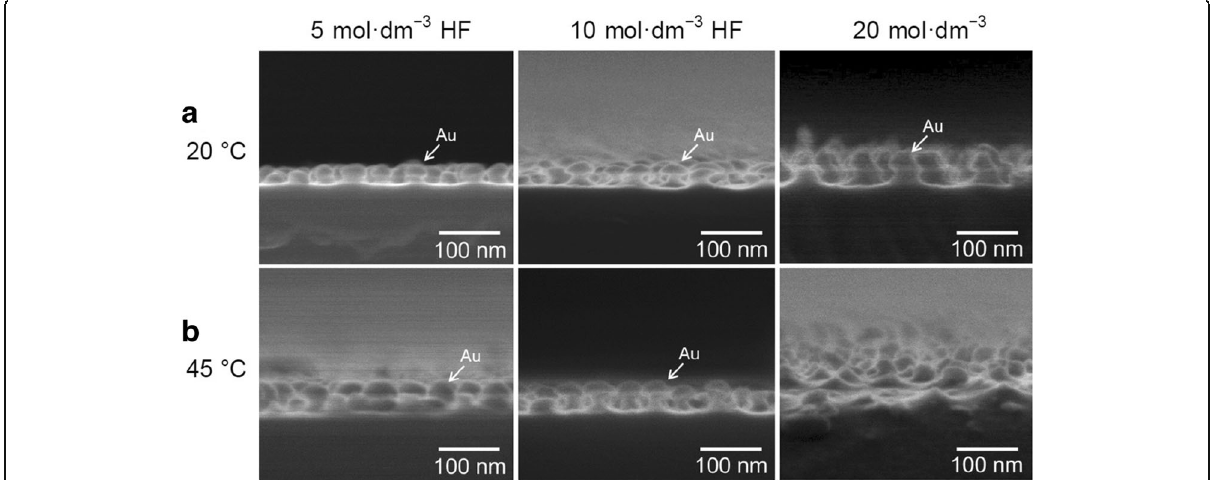
Fig. 4 SEM images of GaAs nanopillar arrays fabricated by Au-assisted chemical etching in solutions containing 0.01 mol dm − 3 KMnO 4 and 5, 10, or 20 mol dm − 3 HF for 5 s at a 20 and b 45